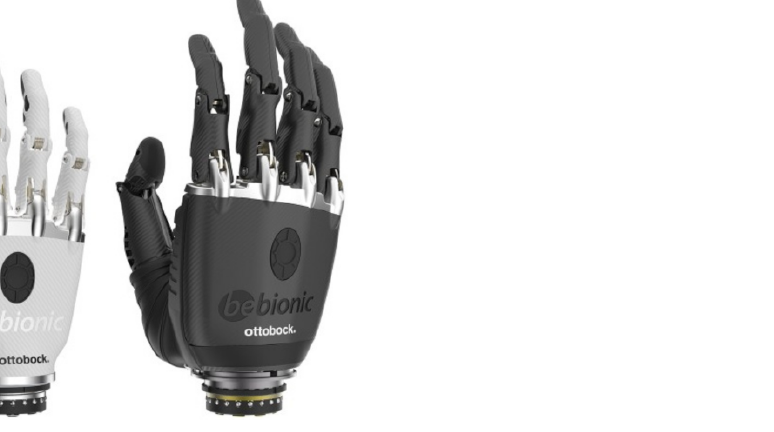
Figure 2. Bebionic 3 robotic hand developed by Ottobock (Photo courtesy from Otto Bock Health- Care LP, 11501 Alterra Parkway Suite 600, Austin, TX 78758, USA).